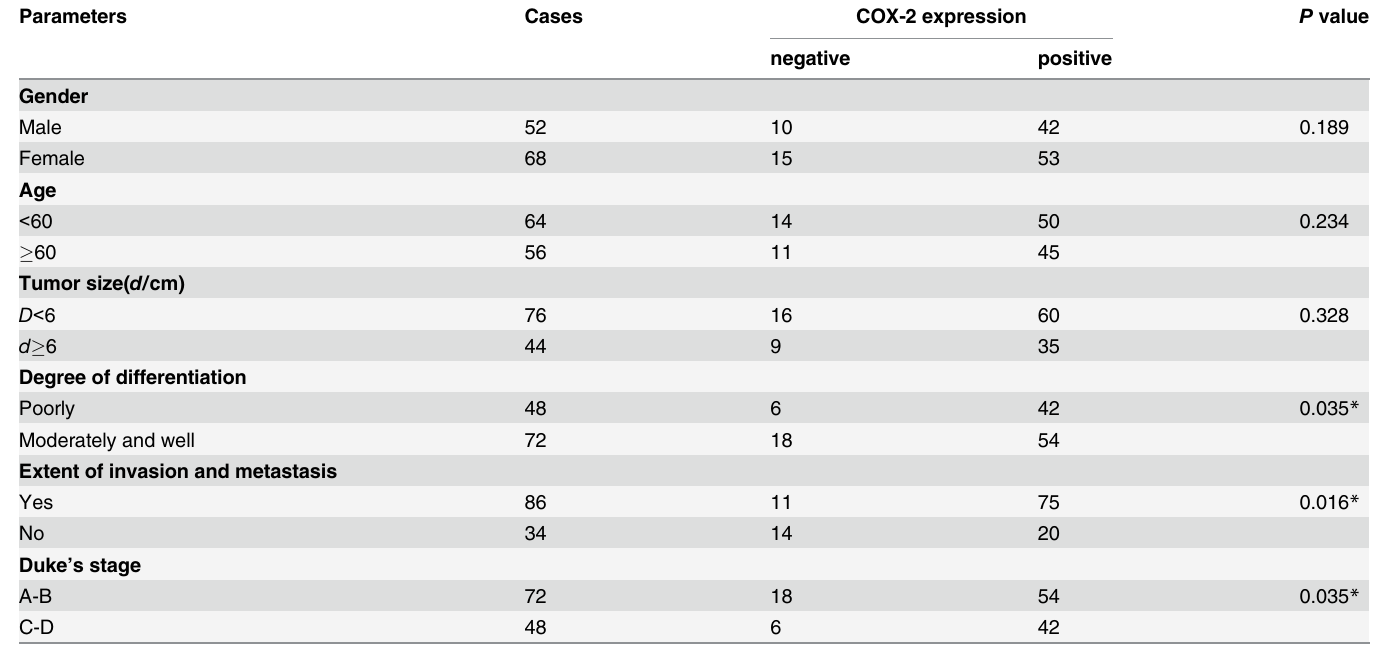
Table 2. Clinicopathologic correlation of COX-2 in human CRCs.